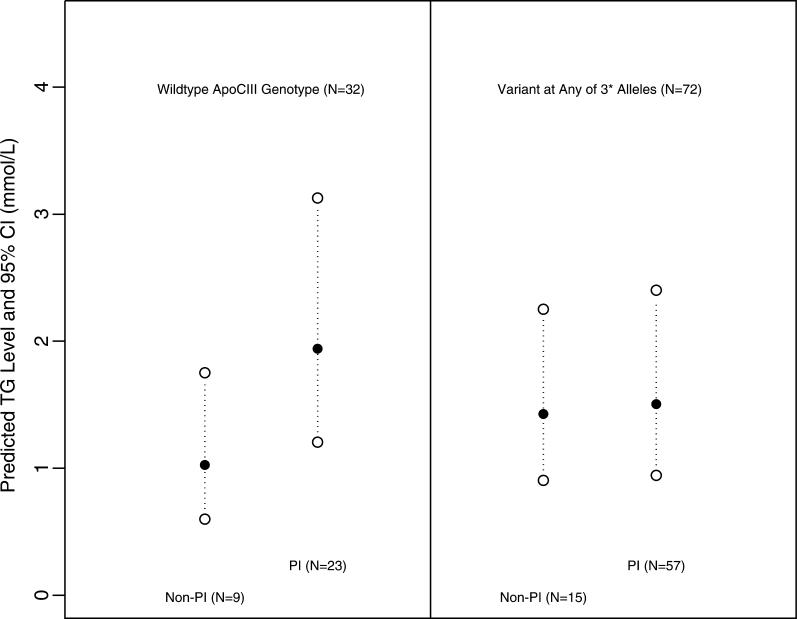
Predicted TG Levels for PI- and Non-PI–Exposed Hispanics by Composite ApoC-III Genotype Variable*ApoCIII-482 (CT/TT), −455 (TC/CC), and/or SstI (3238) CG/GG. The negative effect of PI exposure on TGs is greatly attenuated (56% less) among Hispanics with one or more apoC-III variant compared to Hispanics with the wild-type genotype at these loci (95% CI = [0.32, 0.97], p-value = 0.04.)